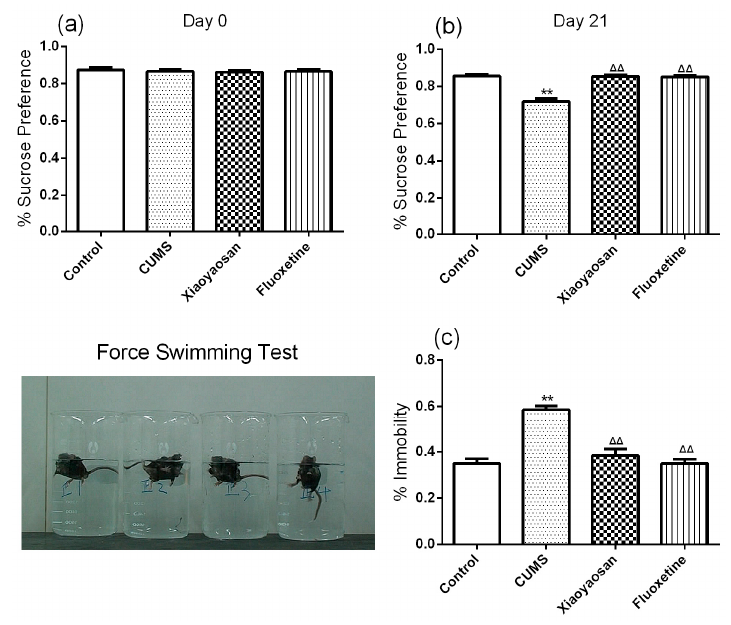
Figure 2. ( a ) SPT of mice in each group at day 0 (baseline); ( b ) SPT of mice in each group at day 21; ( c ) FST of mice in each group at day 21. Data were expressed as means ± SEM ( n = 15), ** p < 0.01 versus control group; ΔΔ p < 0.01 versus CUMS group.